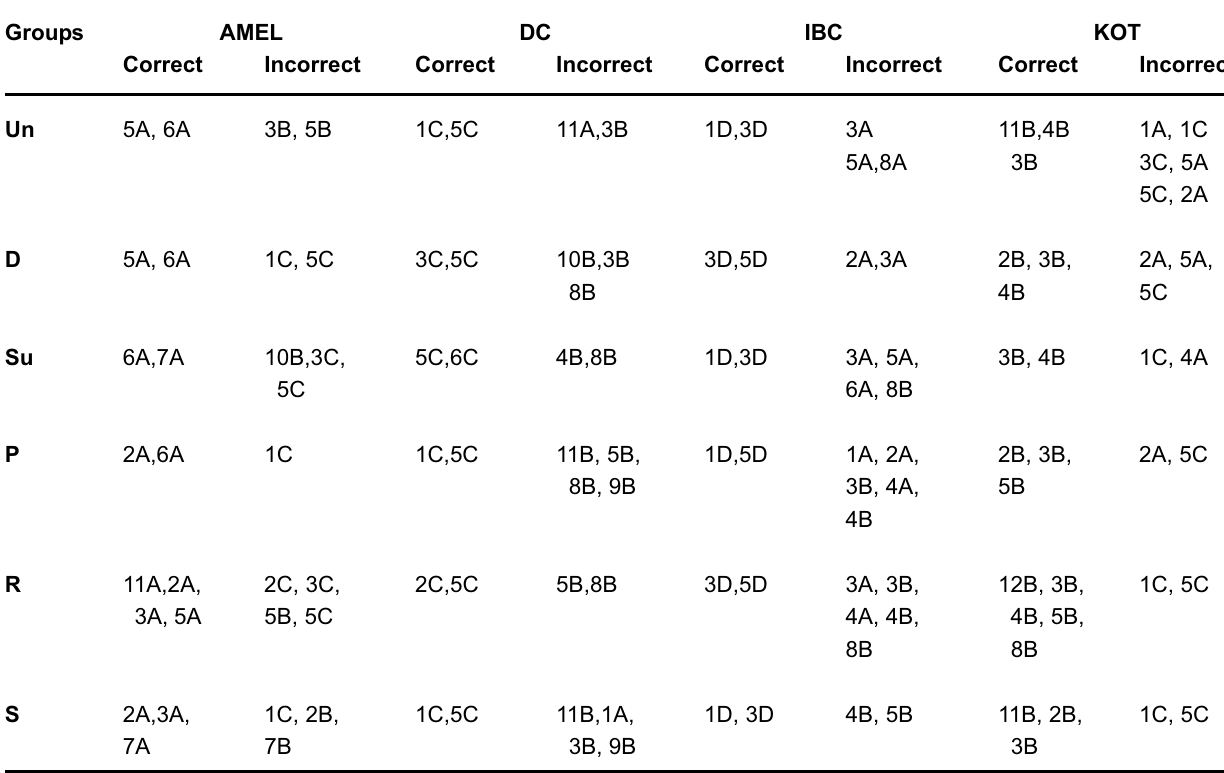
by groups of examiners, according to type of lesion and correct or incorrect 2